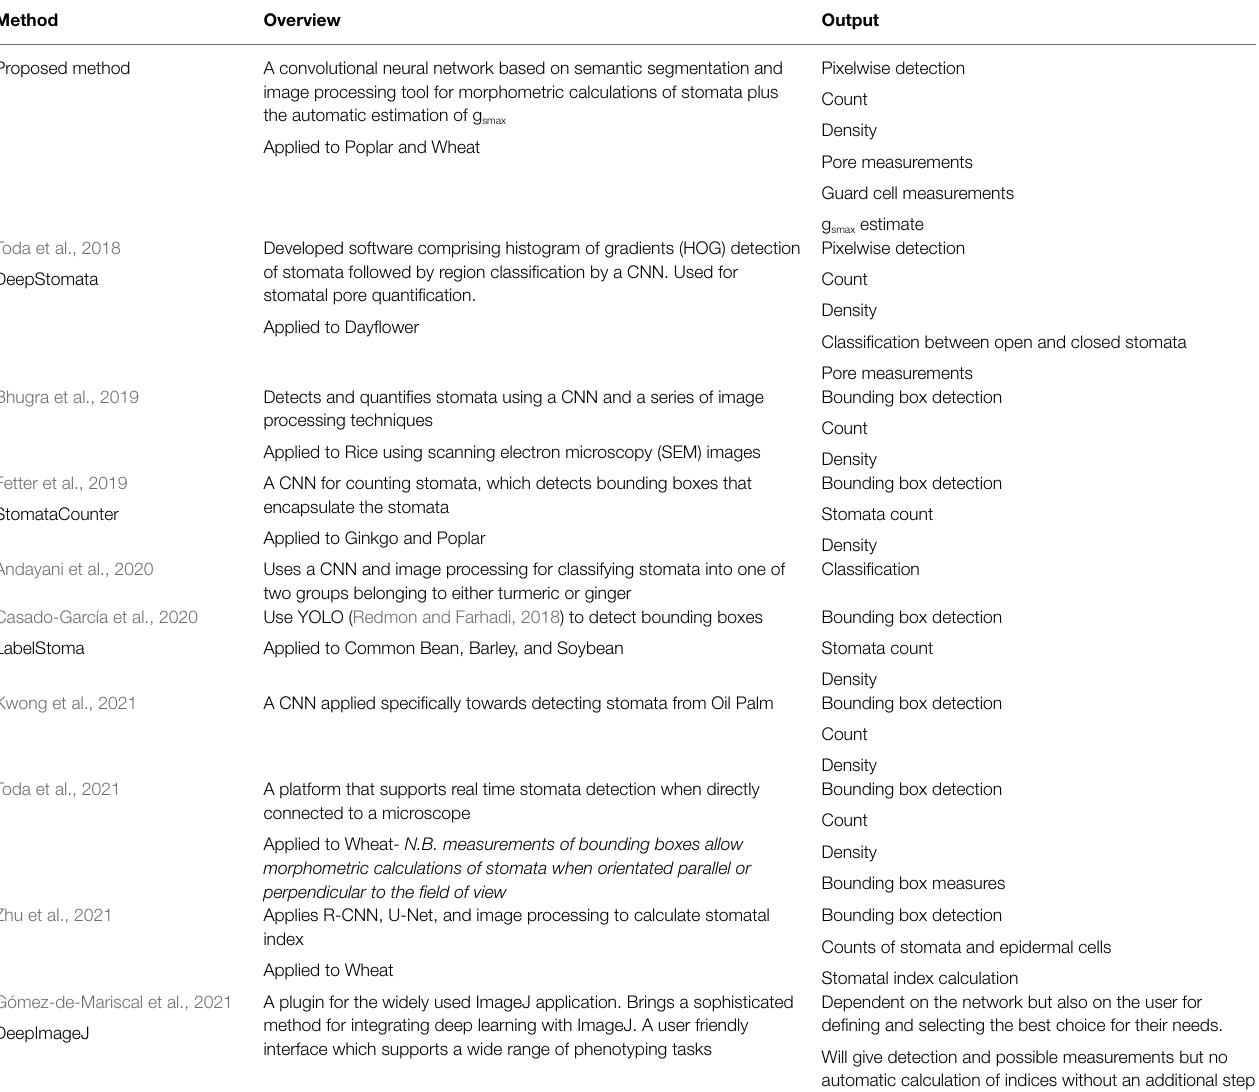
TABLE 3 | Comparison of the proposed method and output compared to other recently published methods.